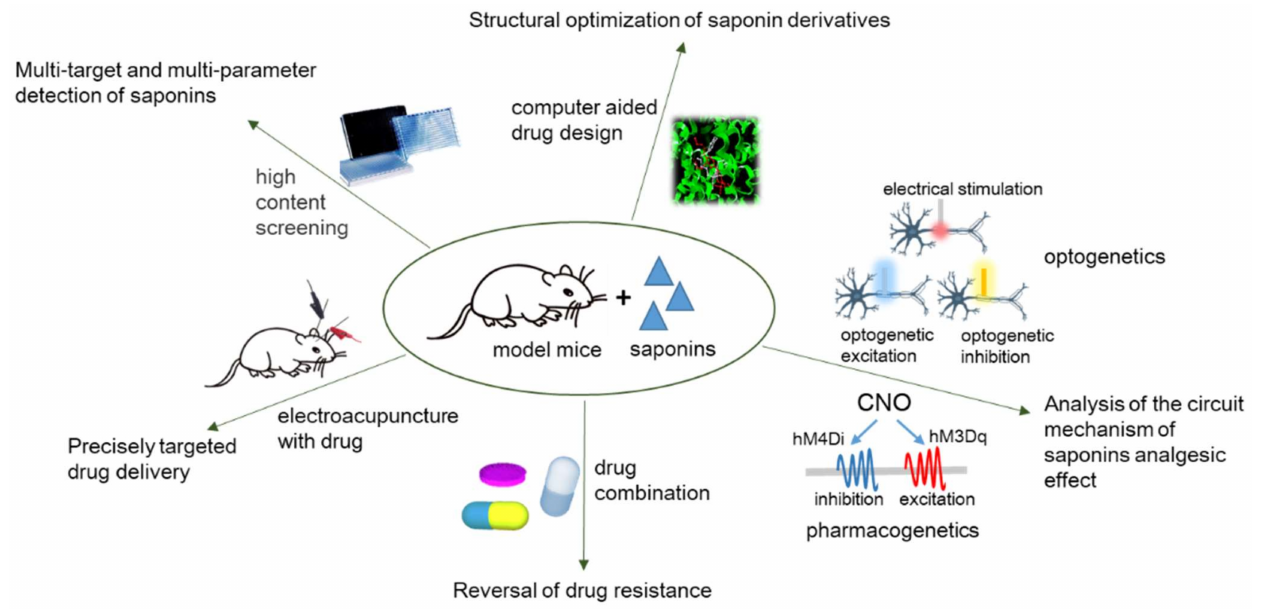
Figure 3. Schematic diagram of the direction of in-depth analysis of saponins in the treatment of neuropathic pain in future